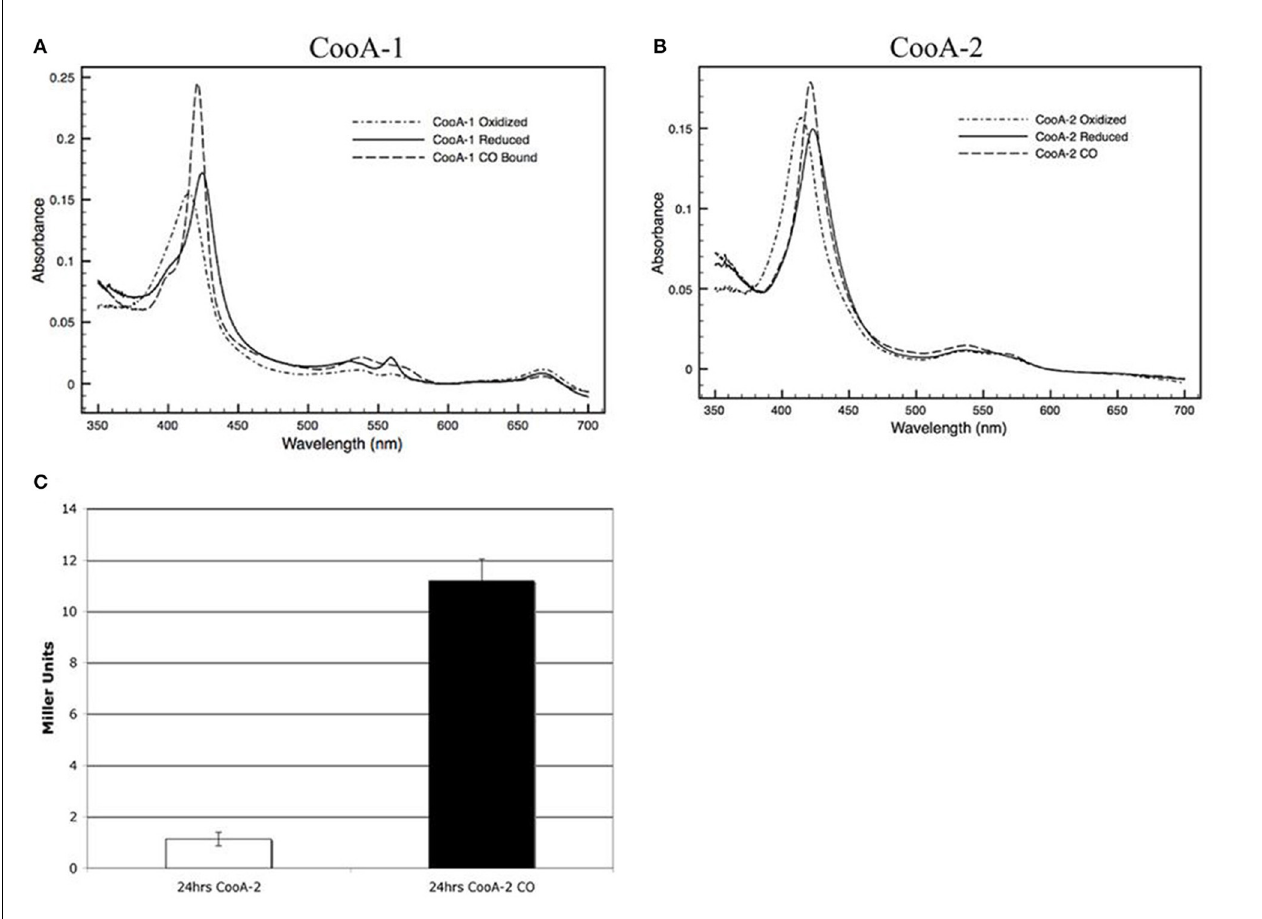
FIGURE 2 |Visible spectra of a 2.2 μ M (A) CooA-1 and (B) CooA-2. Dotted lines indicate the spectrum of oxidized CooA. Solid line indicates reduced CooA. Dashed line indicates reduced CooA under 1atm of CO.